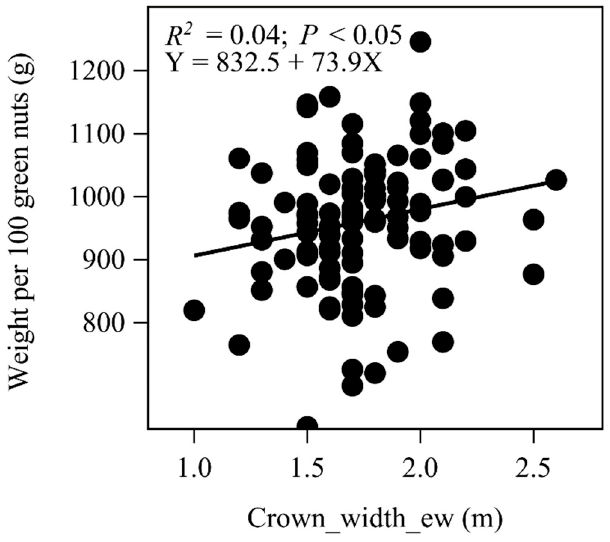
Figure A1. Relationship between weight per 100 green nuts and east–west crown width.